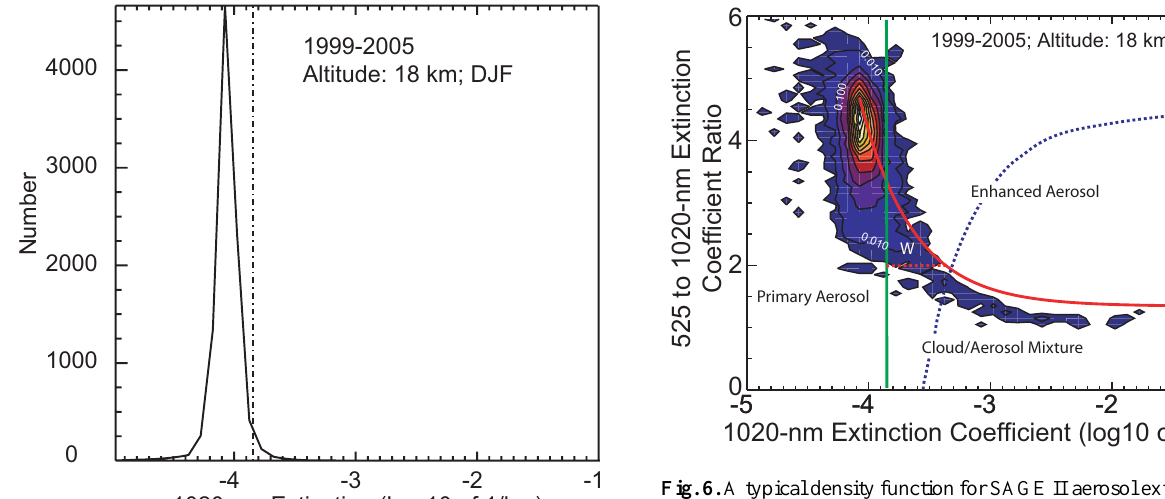
Fig. 6. A typical density function for SAGE II aerosol extinction co- efficient observations at 18km in DJF for 1999 through 2005. The density is scaled to a value of 1 at the peak value with contours at 0.1 increments (0.9, 0.8, etc.) and additional contours at 0.05, 0.01, 0.005 and 0.001. The dotted line shows the approximate po- sition of the “Kent method” cloud aerosol demarcation. The green line shows the separation of primary aerosol (left) from enhanced aerosol and clouds, while the red line (when right of the green line) shows the separation of enhanced aerosol and cloud/aerosol mix- tures. This line is determined by the location of the aerosol centroid, the nominal cloud centroid and Eq. (1) offset upward in extinction ratio by δ (in this case, 0.4). The area denoted by a “W” is the wedge region in which the distinction between aerosol and cloud/aerosol mixtures is particularly